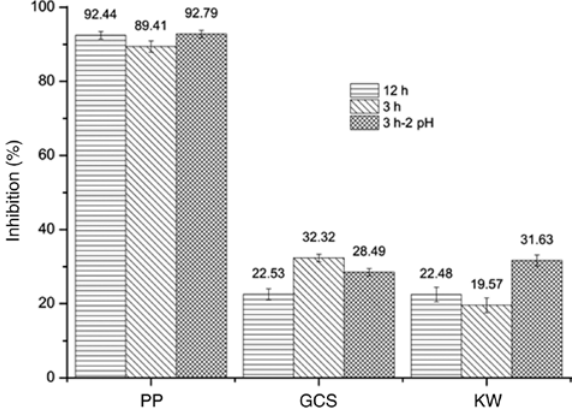
Figure 4: TFC in PP, GCS, and KW extracts for 12 h, 3 h, and 3 h at pH 2